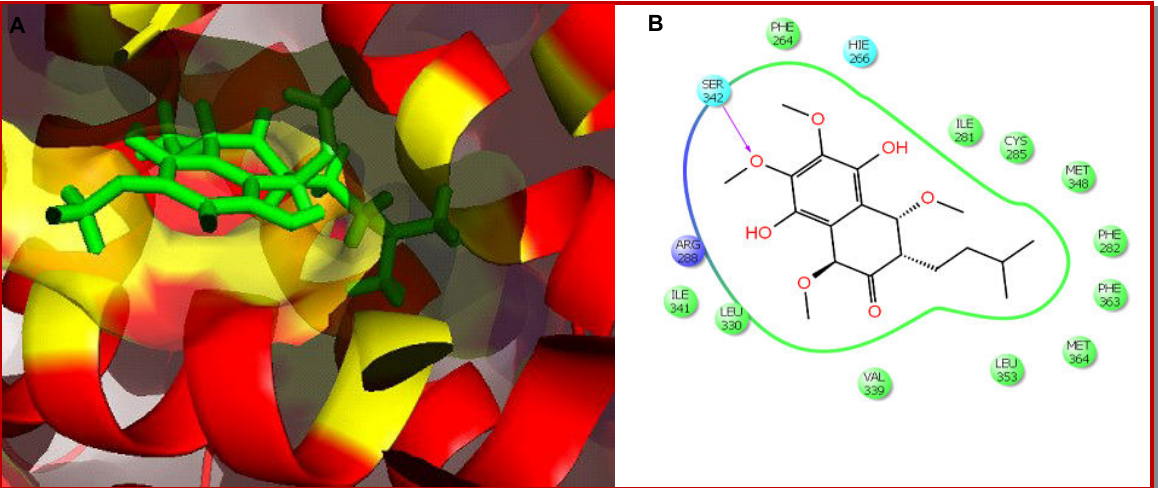
Figure 4: Interaction of C2 compound with PPAR γ predicted using in silico studies. A: Surface view; B: Ligand interaction diagram